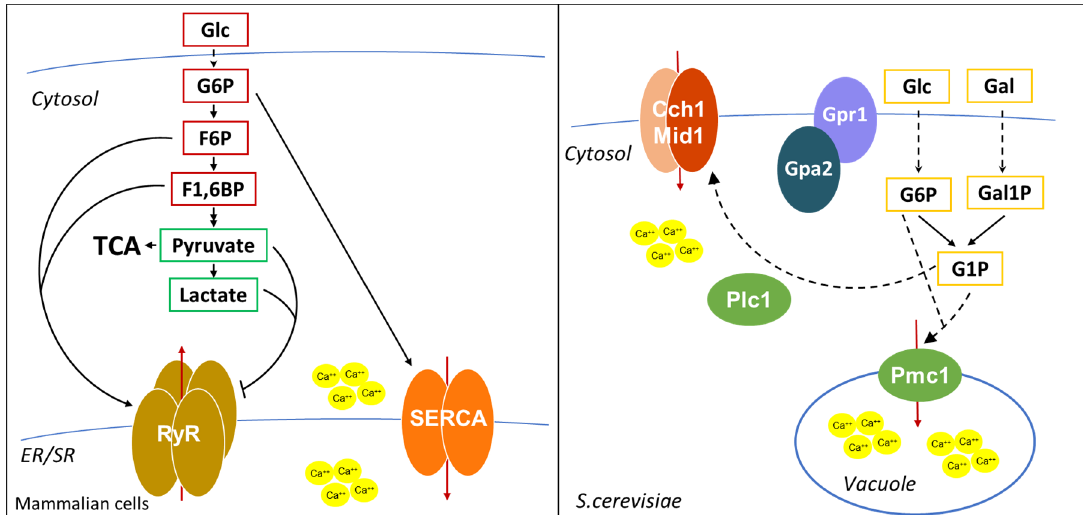
Figure 5. Overview of the effect of glycolytic intermediates on calcium accumulation into the cytoplasm. Metabolites of the upper part of glycolysis (red boxes) are reported to positively influence the activity of RyR channels and SERCA pump, regulating the oscillation of calcium concentration into the cytosol. On the contrary, metabolites of the lower part of glycolysis (green boxes) negatively regulate calcium release from ER/SR through RyR channels. In S. cerevisiae (dotted box) calcium import by the plasma membrane calcium channel is regulated by glucose and galactose availability through their conversion into G6P and G1P.